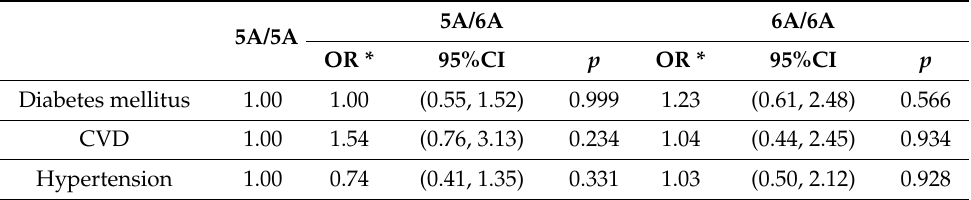
Table 4. Multivariate logistic regression analysis between cardiovascular risk factors and of MMP-3